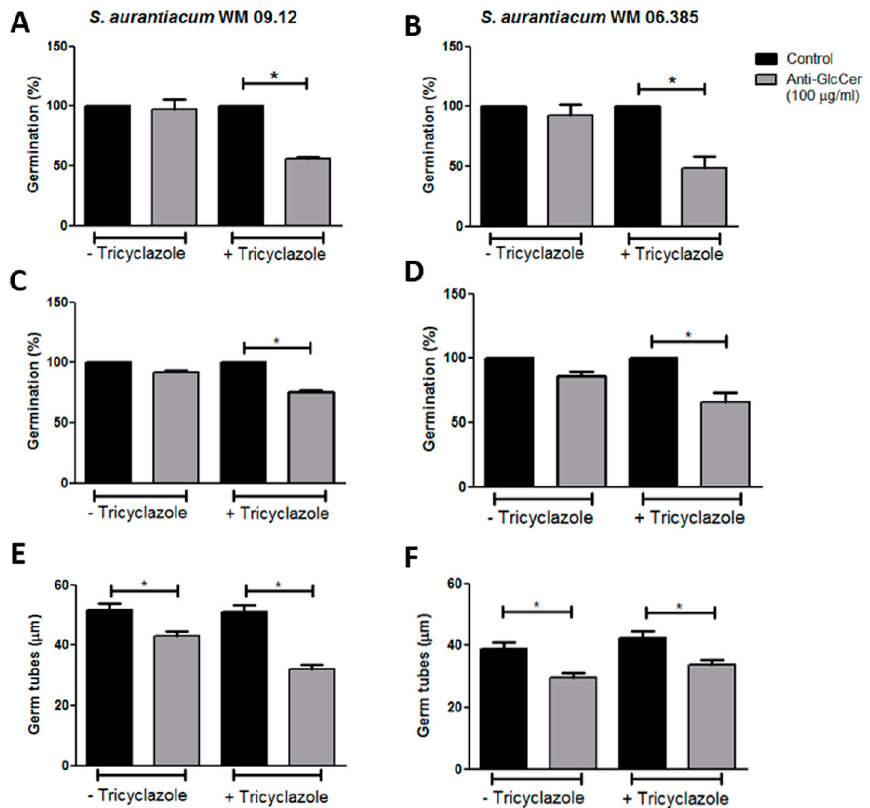
Figure 3. Anti-GlcCer e ff ect in germination of S. aurantiacum WM 09.12 ( A , C , E ) and WM 06.385 ( B , D , F ). Germination rates of S. aurantiacum conidia in the presence of anti-GlcCer (100 µ g / mL) for 3 h ( A , B ) and 6 h ( C , D ). Germ tube lengths were measured after 6 h of germination with anti-GlcCer ( E , F ). Conidia were cultivated in the absence ( − Tricyclazole) or presence ( + Tricyclazole) of tricyclazole (16 µ g / mL). * p < 0.05.